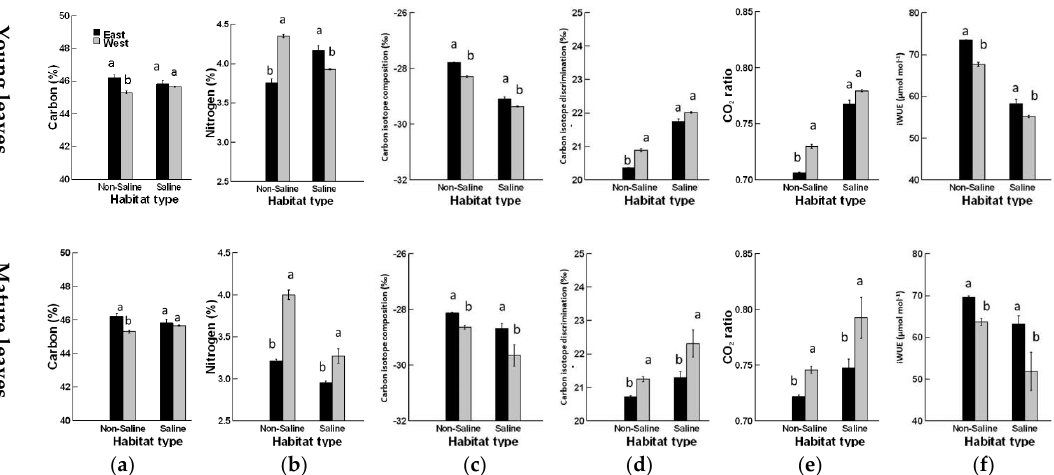
Figure 1. E ff ects of habitat type (saline vs. non-saline), canopy position (east and west) and leaf age (young and mature) on ( a ) carbon (%), ( b ) nitrogen (%), (c) carbon isotope composition (% (cid:24) ), ( d ) carbon isotope discrimination (% (cid:24) ), ( e ) C i / C a ratio, and ( f ) intrinsic water-use e ffi ciency (iWUE) of Prosopis